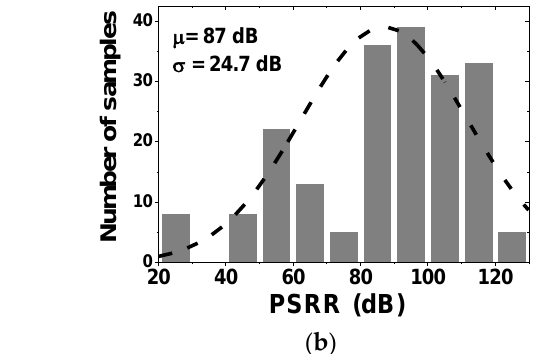
Figure 14. Simulation results of the proposed CCIA: ( a ) Spectrum output voltage with and without A-OCL; ( b ) Monte Carlo simulation of the attenuation ripple. To verify the linearity of the amplifier, an FFT of output voltage is analyzed with a differential input of 2 mV and an input frequency of 100 Hz (Figure 15). The total har- monic distortion was about −5 6.2 dB, which is determined by the ratio between the output amplitude at the input frequency and its third-order harmonic of 300 Hz, given that the fifth- and seventh-order harmonics are small enough to be ignored. The power breakdown of the proposed CCIA is given in Table 2. The power effi- ciency factor (PEF) is used to evaluate the tradeoff between noise and power efficiency for biopotential amplifiers. As in [18], PEF is calculated as follows: 2